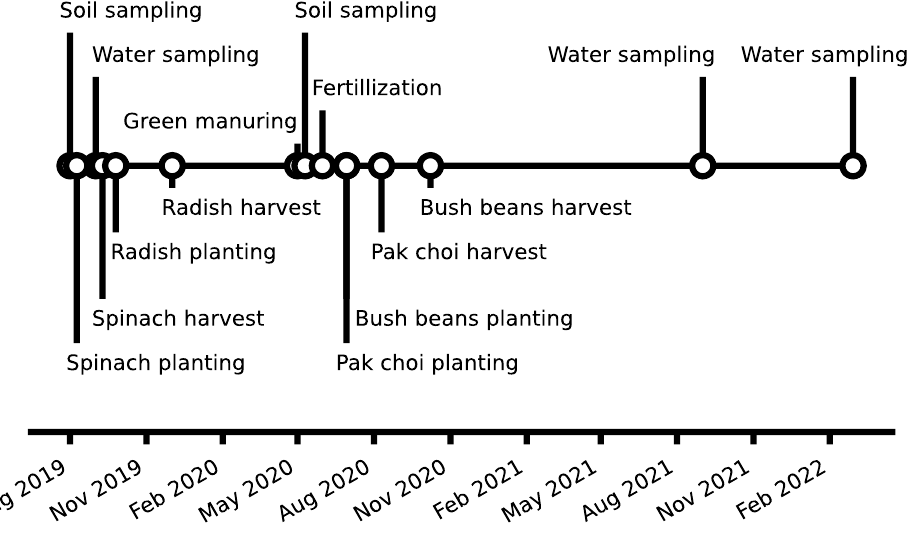
Figure 1. Timeline and events of the raised bed